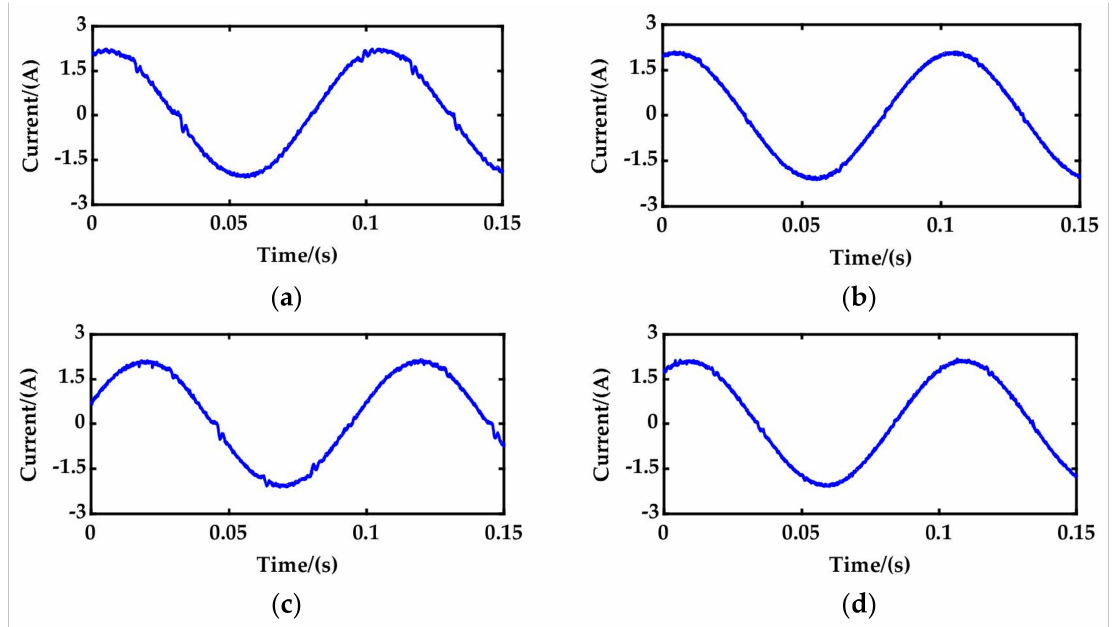
Figure 11. Phase A currents under i d = 0, 150 r/min and 1 N · m load. ( a ) Compensation for PMSM FOC system with conventional DM–CZD. ( b ) Compensation for PMSM FOC system with proposed DP–CZD. ( c ) Compensation for current predictive control of PMSM with conventional DM–CZD. ( d ) Compensation for current predictive control of PMSM with proposed DP–CZD.